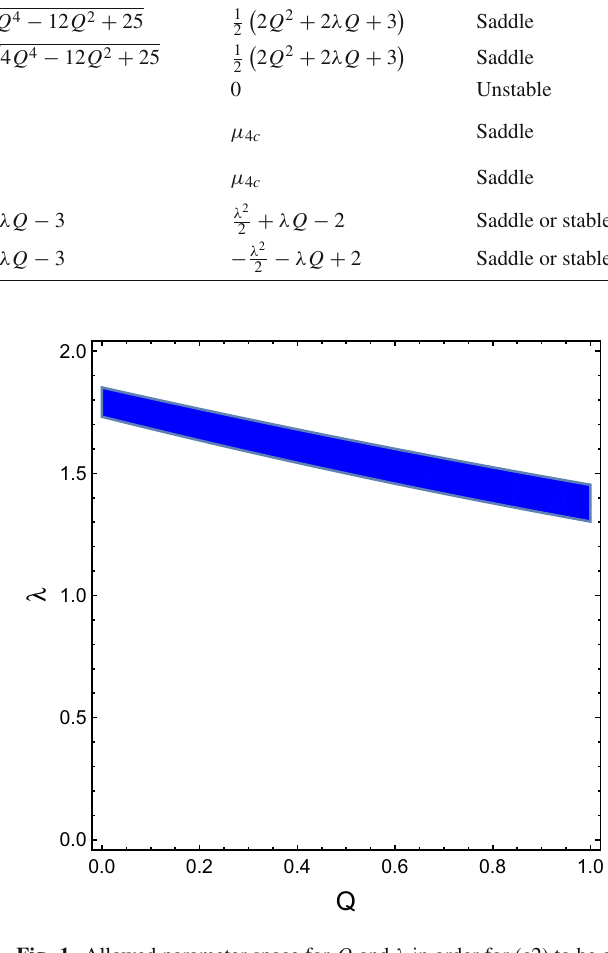
Fig. 1 Allowed parameter space for Q and λ in order for (c2) to be a stable point. These possible values of λ are ruled out by current cosmo- logical observations